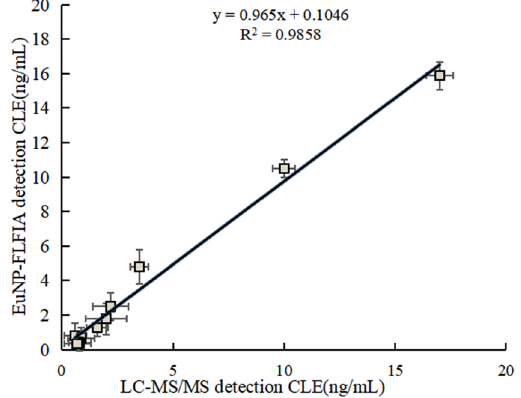
Figure 5. EuNP-FLFIA and LC-MS/MS comparison test results.